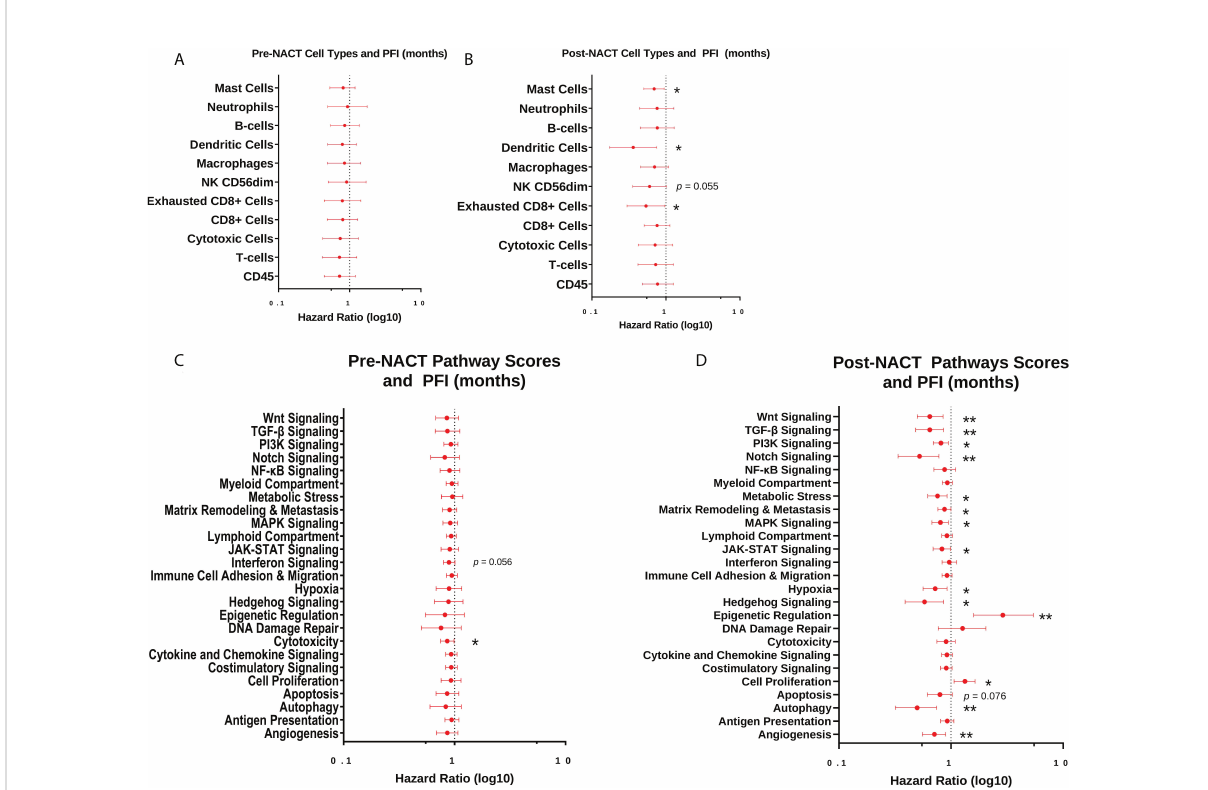
FIGURE 8 Post-NACT gene expression, pathway, and immune cell changes correlate with platinum free interval (PFI). Forest plot showing Cox proportional hazards regression of pre-NACT immune cell types (A) , post-NACT immune cell types (B) , pre-NACT pathway scores (C) , and post-NACT pathway scores (D) using PFI as the response variable. Log10 hazard ratios are indicated on the x-axis. Bars indicate 95% con fi dence interval. *p<0.05;